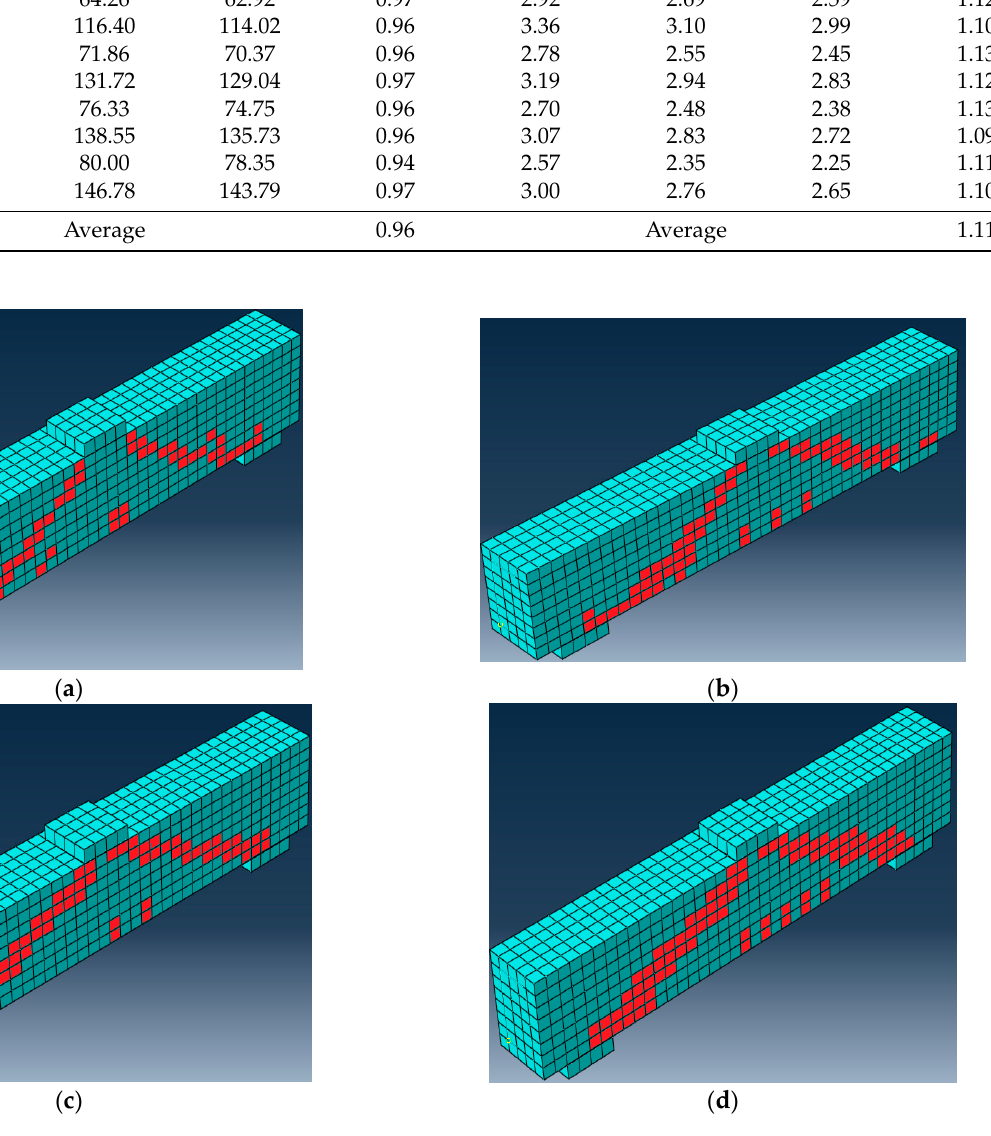
Figure 10. FE final cracks of some specimens. ( a ) Specimen B1; ( b ) Specimen B2; ( c ) Specimen B5; ( d ) Specimen B6.